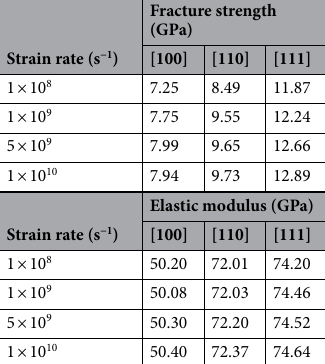
Fracture strength